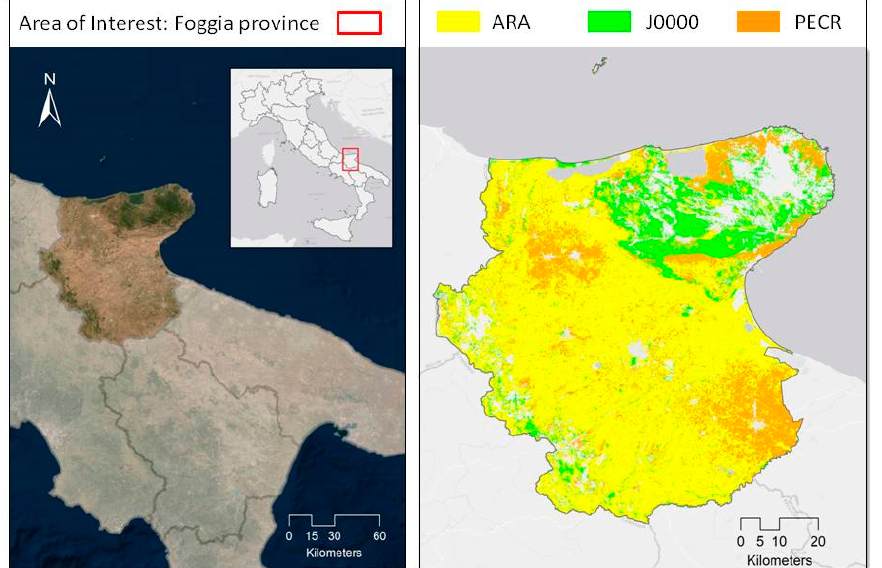
Figure 2. Agricultural areas in Foggia province classified by arable land; permanent crops; perma- nent